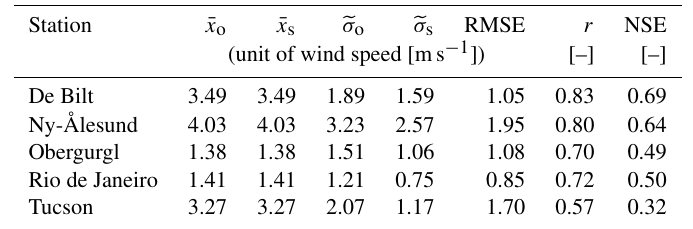
Table 5. Model performance measures for wind speed disaggregation (W2 model). ¯ x o and ¯ x s are the mean values of observed and disaggre- gated wind speed, respectively. The standard deviation of the observed ( e σ o ) and disaggregated ( e σ s ) time series are also specified. The root mean square error (RMSE), the correlation coefficient r , and the Nash–Sutcliffe model efficiency (NSE) are calculated using the observed and disaggregated time series for each station.